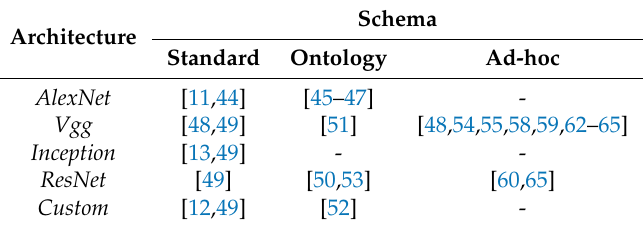
Table 2. Usage of object detection architectures in the reviewed